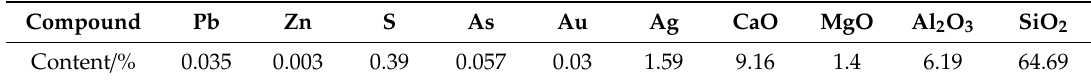
Table 1. Chemical characteristics of the tailings.